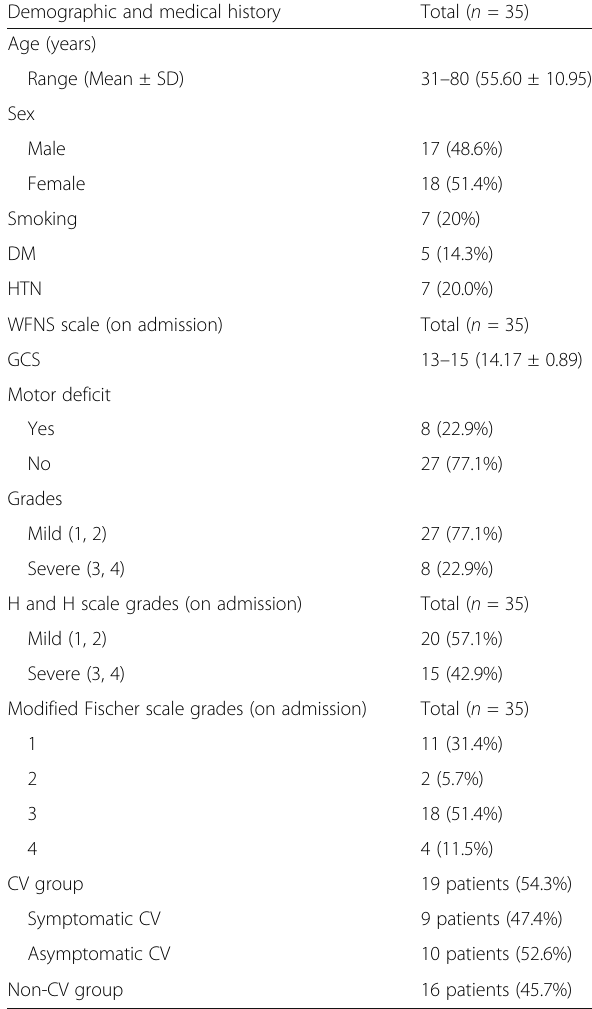
Table 1 Demographic, medical history, WFNS scale, Hunt and Hess scale, and modified Fisher scale in study group